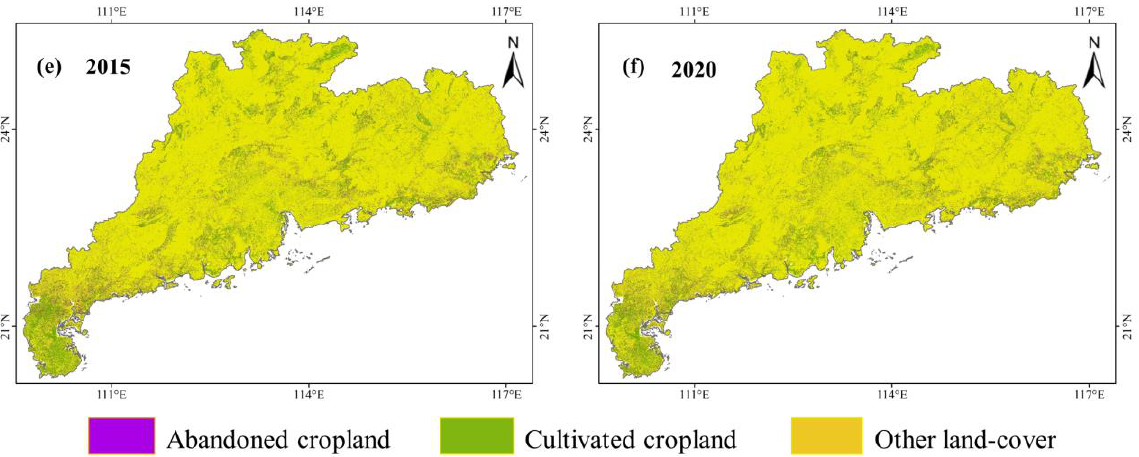
Figure 12. Annual cropland abandonment maps of Guangdong in 1995(a), 2000(b), 2005(c), 2010(d), 2015(e), and 2020(f).